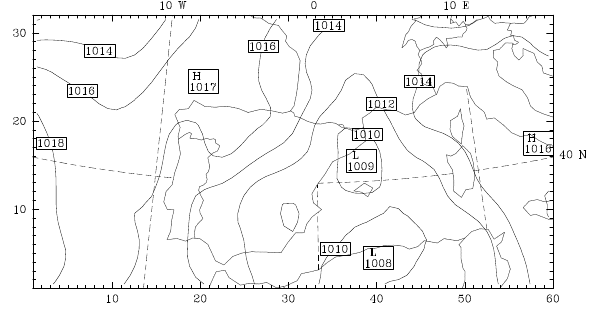
Fig. 2. The sea level pressure (hPa) distribution of the convective situation at 19:00 UT on 14 September